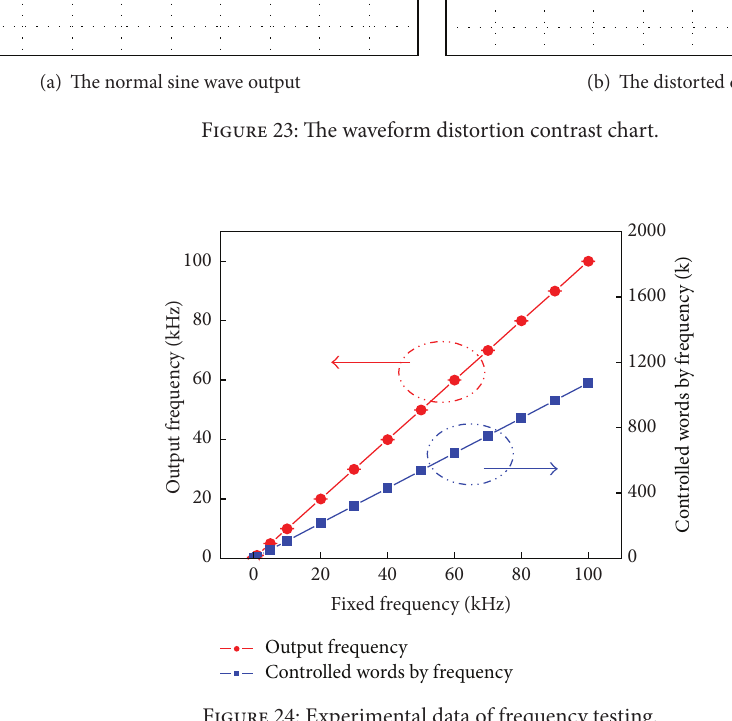
Figure 24: Experimental data of frequency